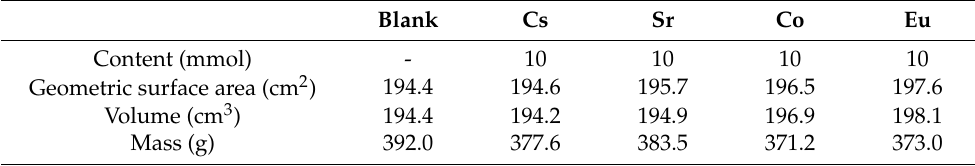
Table 1. Chemical composition (wt.%) of OPC as determined by X-ray fluorescence analysis.